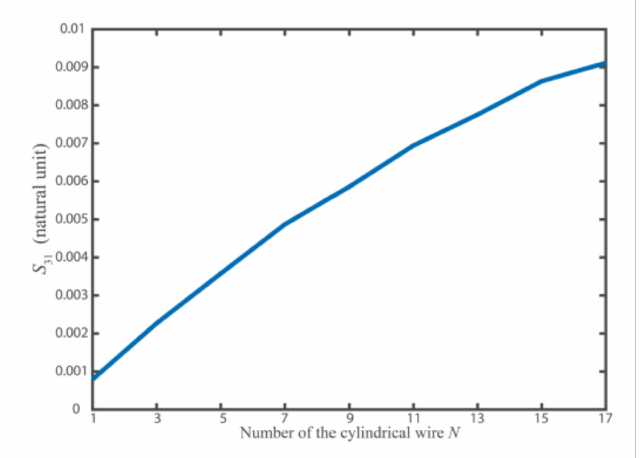
Figure 13. Reflection coefficient R ( S 31 ) of Gaussian beam with a different number of cylindrical wire at 330 GHz.